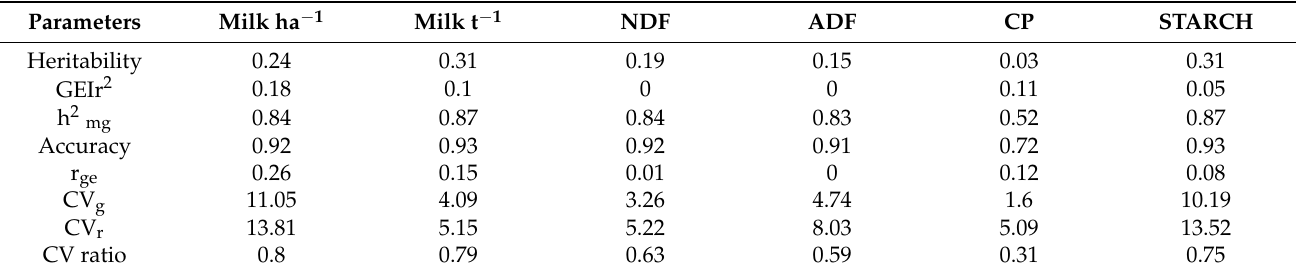
Table 3. Genetic parameters of quality traits.